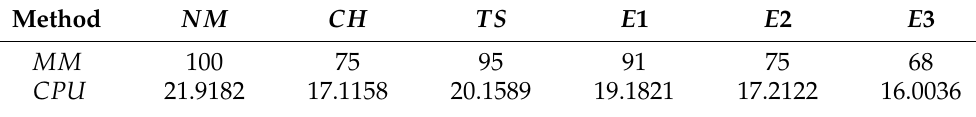
Table 10. Results of Example (7) case (b) for γ = 0.5 and θ = 0.3.